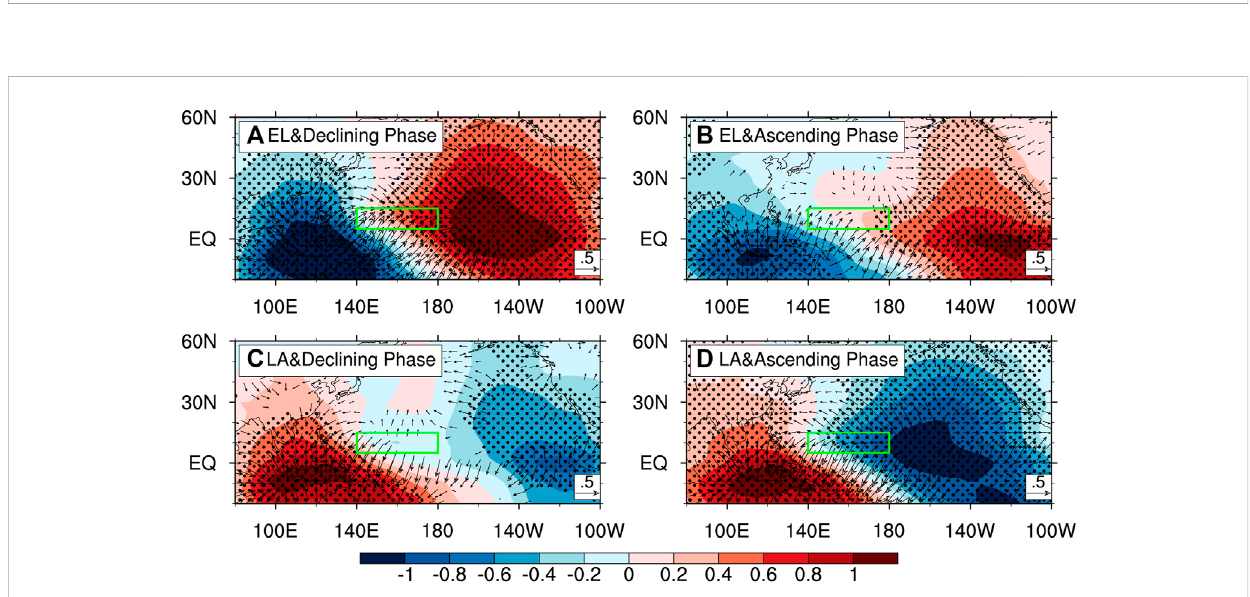
FIGURE 6 Composite velocity potential anomalies (shaded; units: 10 6 m 2 s − 1 ) and divergent wind anomalies at 925 hPa (vector; units: m s − 1 ) in JJASON in (A) , (B) ElNiñoand (C) , (D) LaNiñayearsduringdifferentsolarcyclephases.Dots(vectors)indicatevelocitypotential(divergentwind)anomaliesaresigni fi cant at the 99% con fi dence